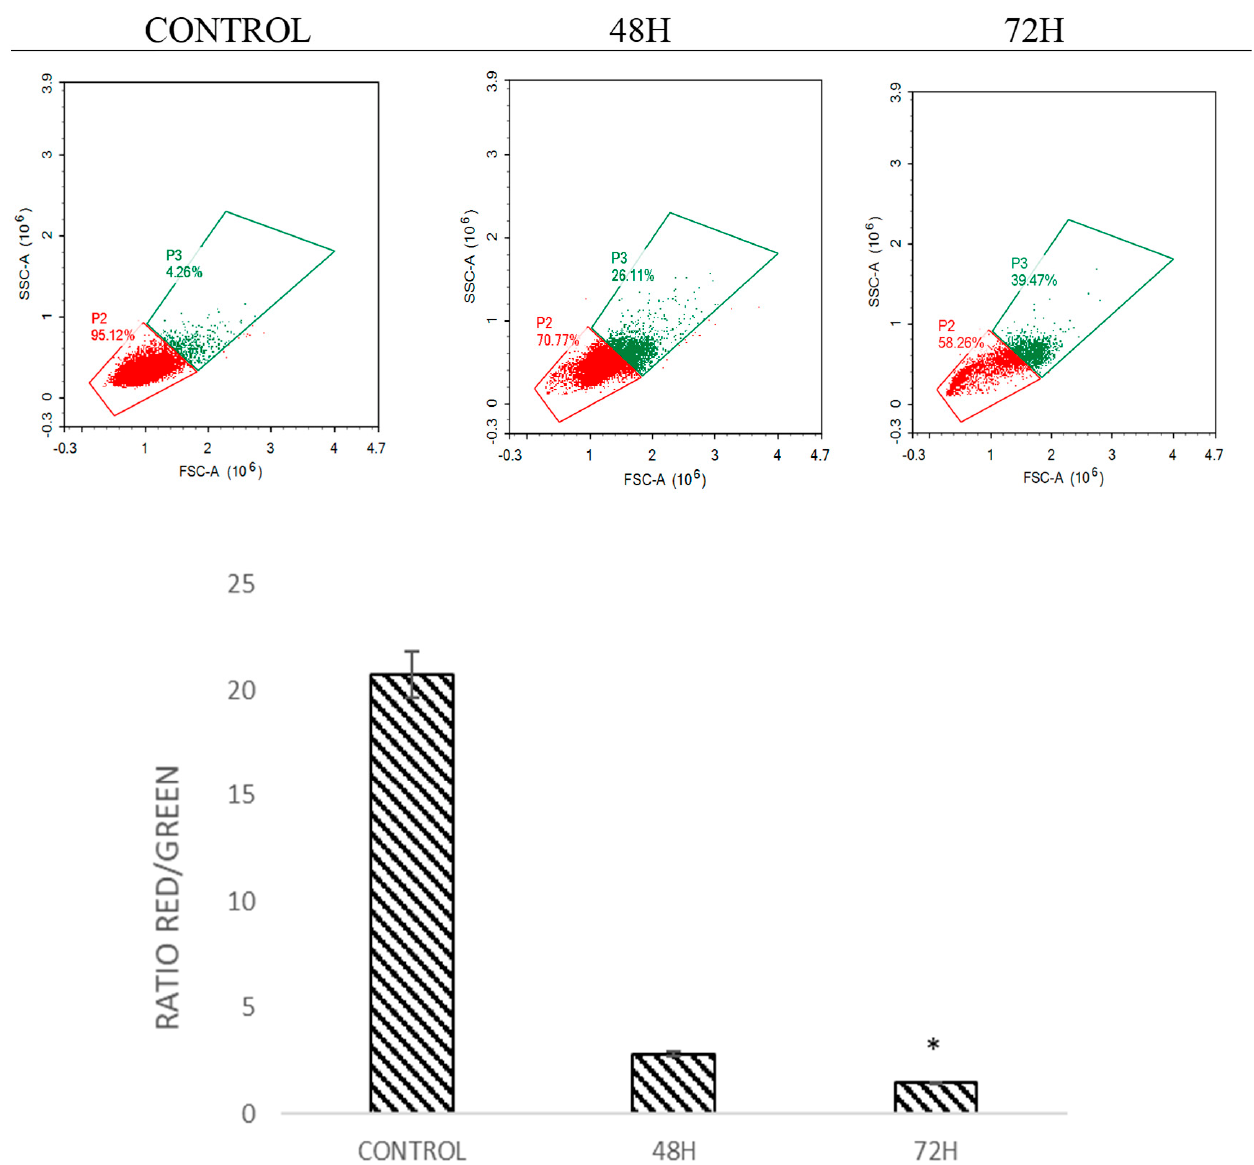
Figure 7. Histogram and quantification analysis of the depolarization of mitochondrial membrane potential for SW620 after being treated with DMCH for 48 h and 72 h. All data are expressed as mean ± standard error mean (S.E.M.). * p < 0.05 compared with corresponding controls.